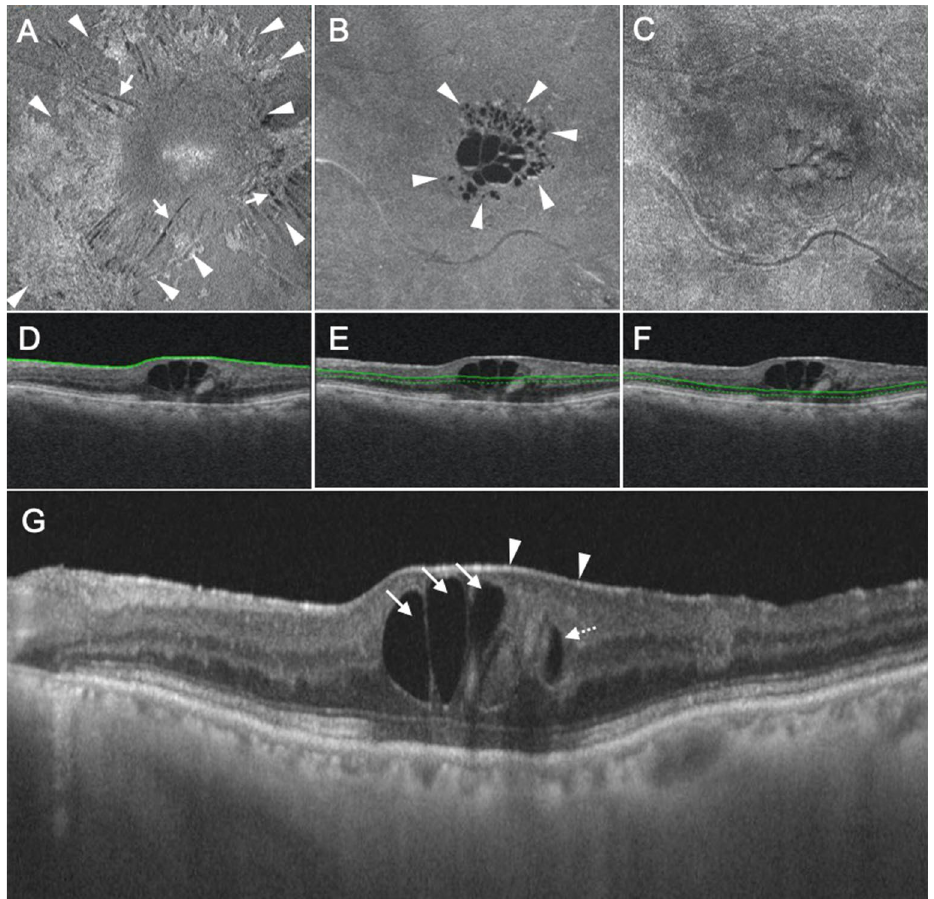
Figure 2. Representative case showing the parafoveal cystoid space at Segment 1/no fluid at Segment 2 type of diabetic macular edema. ( A – C ) En face images of the retinal surface ( A ), Segment 1 ( B ), and Segment 2 ( C ) are presented. Epiretinal membrane (arrowheads in A ) and associated retinal folds (arrows in A ) can be observed at the surface of the retina ( A ). There are cystoid spaces at Segment 1, with fluid remaining within the parafovea (arrowheads, B ). There is no fluid at Segment 2 ( C ). ( D – F ) B-scan images and the green lines show the locations at which the en face images of the retinal surface ( D ), Segment 1 ( E ), and Segment 2 ( F ) were generated. The scan depth, indicated by the distance between the green line and green dotted line, was set to 0 μm for the en face image of the retinal surface ( D ) and 50 μm for the en face images of both Segments 1 and 2 ( E , F , respectively). ( G ) A horizontal B-scan image centered at the fovea is presented. Parafoveal cystoid spaces are located at both Henle’s fiber layer (arrows) and the inner nuclear layer (dotted arrows). The arrowheads in ( G ) indicate the epiretinal